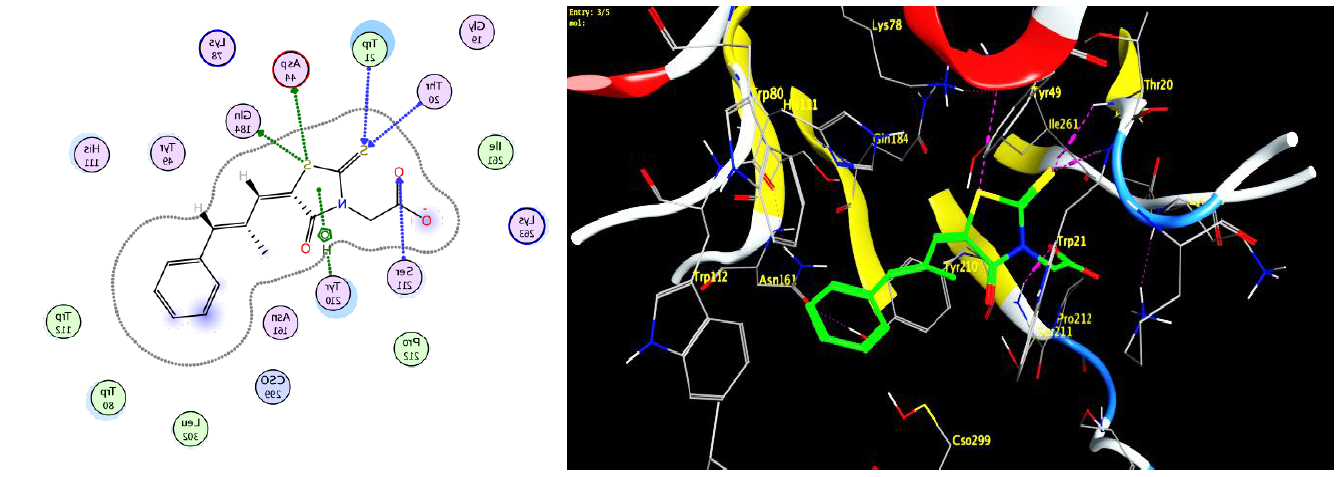
Figure 9. 2D and 3D docking of compound 12b with PPAR γ . The modeling for Epalrestat in AKR1B10 illustrates the carbonyl oxygen and two sulfur groups form hydrogen bonds with SER 211, GLN 184, ASP 44, THR 20, and TRP 21 and hydrophobic interaction with TYR 210 (Figure 10).